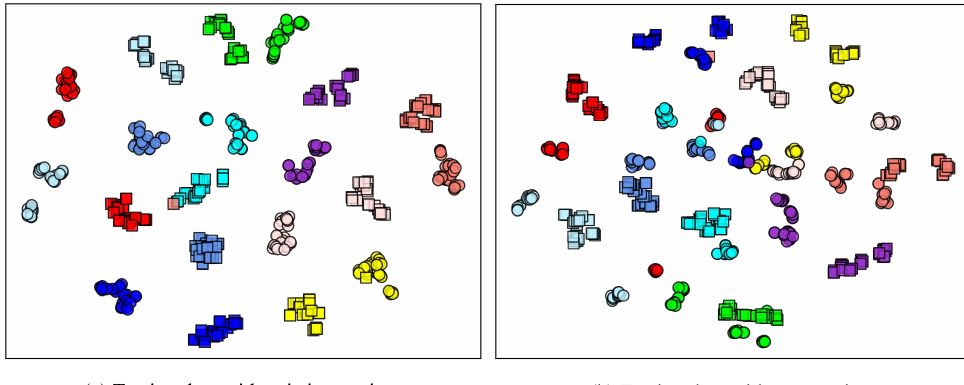
Figure 9. Visualization of the feature extracted with AGW [8] distributions. A total of 10 IDs are randomly selected from the testing set of SYSU-MM01. Here, samples with the same color indicate they are of the same person. The markers “circle” and “square” represent the images from infrared and visible modalities,